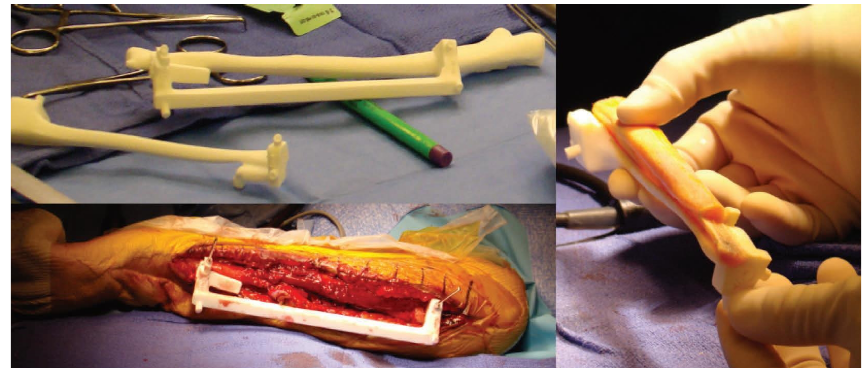
Figure 5: Patient 4 afected by a diaphyseal Ewing’s sarcoma of the ulna. Left top: the tridimensional model of the patient ulna, the PSI for tumor cutting, and the PSI for allograft cutting are on the surgical table. Left bottom: the PSI for tumor resection is fxed to the patient’s ulna. Right: the allograft and the PSI for allograft cutting.